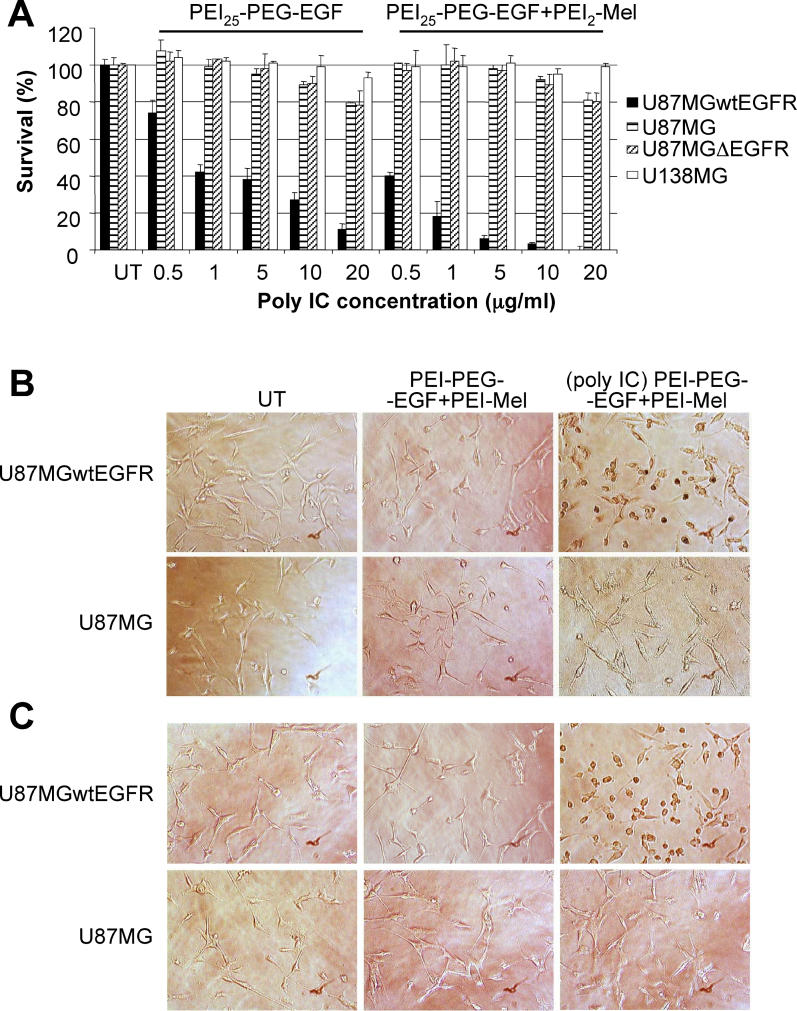
(poly IC)PEI-PEG-EGF(+PEI-Mel) Complexes Selectively Kill U87MGwtEGFR Cells(A) Cells were seeded in duplicate onto a 96-well plate at a density of 5,000 cells in 0.2 ml of medium per well and grown overnight. Cells were then transfected as described [6,9] with poly IC at the indicated concentrations using either PEI-PEG-EGF or PEI-PEG-EGF+PEI-Mel (w/w ratio PEI-PEG-EGF:PEI-Mel = 1:10) complexes. Viability was measured by the CellTiter-Glo Luminescent Cell Viability Assay (Promega) according to the manufacturer's instructions, at 1 h after transfection.(B and C) Fast induction of apoptosis by (poly IC)PEI-PEG-EGF+PEI-Mel complexes. Apoptotic death was detected 1 h after transfection by Annexin (B) and TUNEL (C) assays as described in Methods.